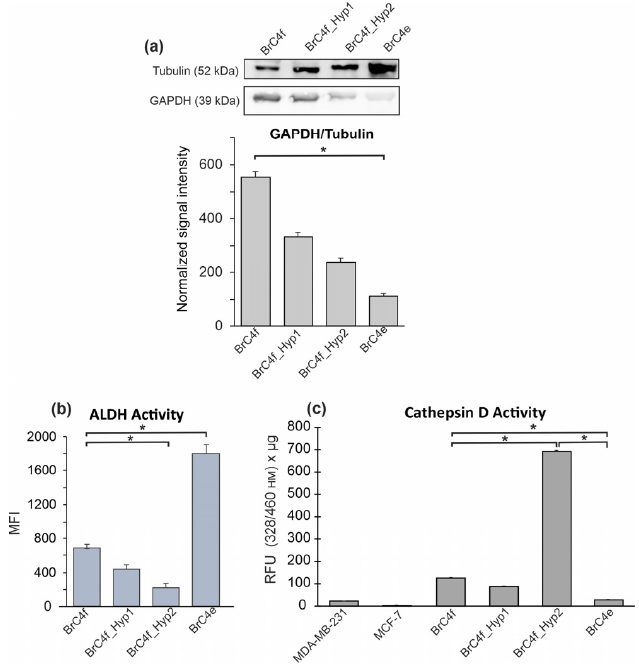
Figure 6. Analysis of metabolic enzymes in established cell lines. ( a ) Western blot analysis of GAPDH level. ( b ) Alterations of ALDH activity in the cells. ALDEFLUOR™ kit assay measurements of ALDH activity by flow cytometry. ALDH converts the ALDH substrate, BAAA(BODIPY- aminoacetaldehyde), into the fluorescent product BAA-(BODIPY-aminoacetate), which is retained inside viable cells and detected through use of the green fluorescence channel (emission wavelength of 585–595 nm). Flow cytometry data are presented as mean fluorescent intensity (MFI) of the cells ± SD. ( c ) CatD activity in the cells. MDA-MB-231 cells and MCF7 cells were used as internal control. The data are presented as mean value ± SD of cellular fluorescence in relative fluorescent units (RFU) per microgram of total protein amount in the sample. Data are of three independent experiments. The differences between two groups were significant (* p <